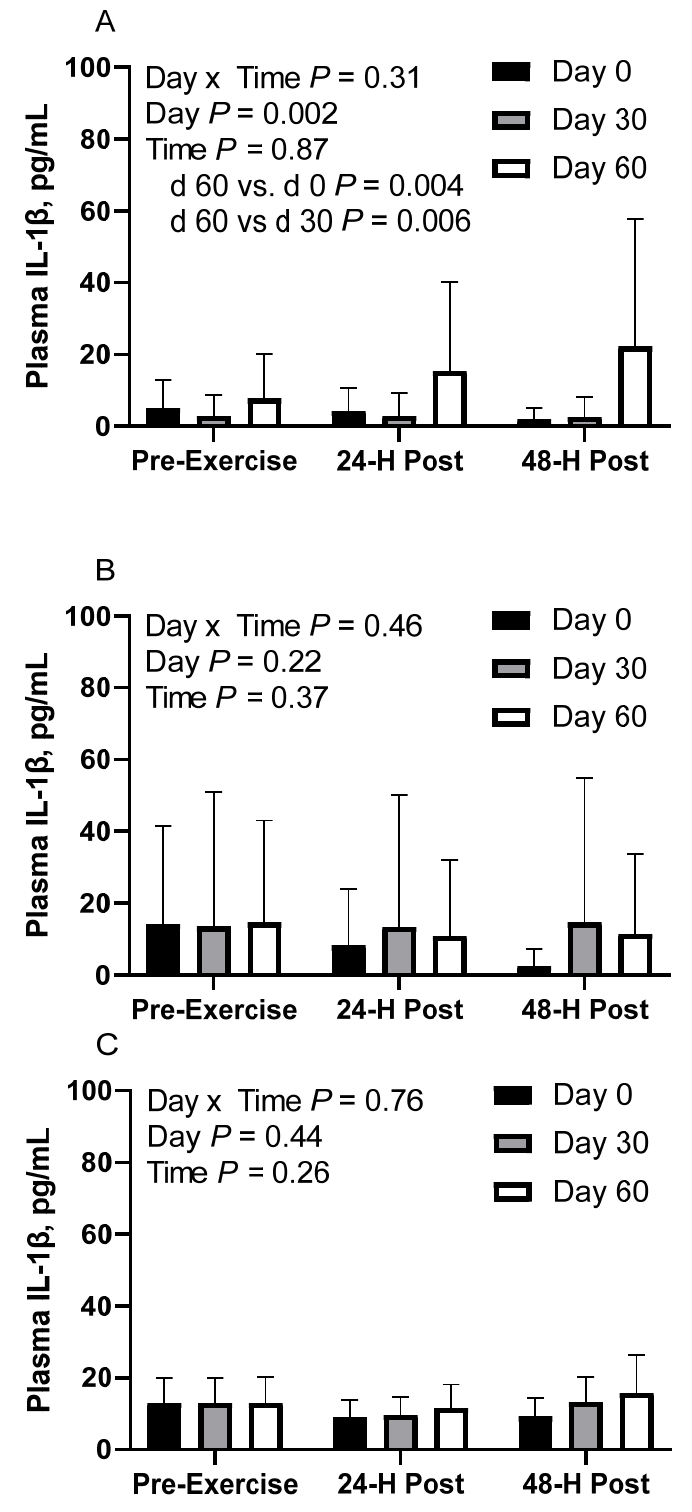
Figure 4. Geometric mean [LCI, UCI] fasting, 24 h post-exercise, and 48 h post-exercise plasma interleukin-1 β concentrations in young horses fed 60% energy from hay (coastal bermudagrass) and 40% energy from concentrate (SafeChoice Original, Cargill Animal Nutrition, St. Paul, MN, USA) on d 0, 30, and 60 of a 60-day feeding trial. Where CON ( A ) did not receive dietary alteration, FLAX ( B ) had 25% of concentrate calories replaced with a flaxseed oil blend, and RICE ( C ) had 25% of concentrate calories replaced with crude rice bran oil.